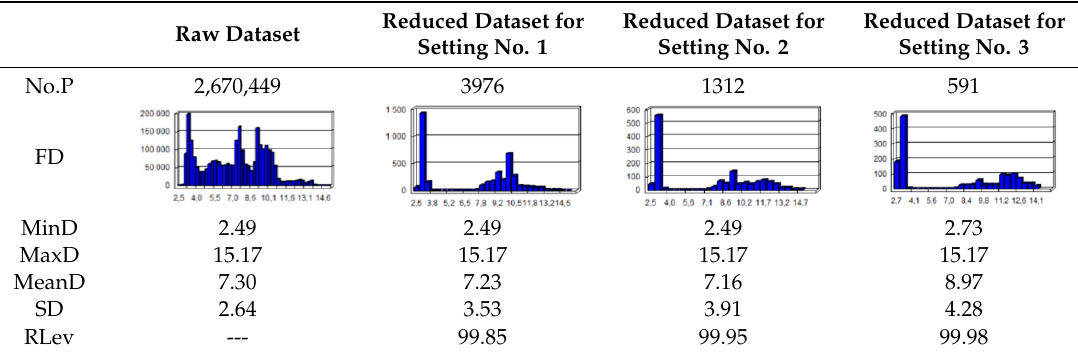
Table 4. Statistics for points reduced with the OptD method based on the LNG port area.